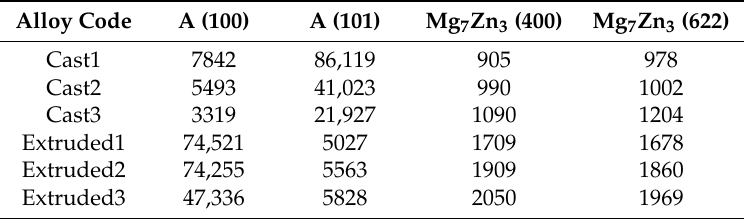
Figure 1. XRD patterns of the Mg alloys. Table 2. Intensity of main peaks for α phase and Mg 7 Zn 3 (cps.).